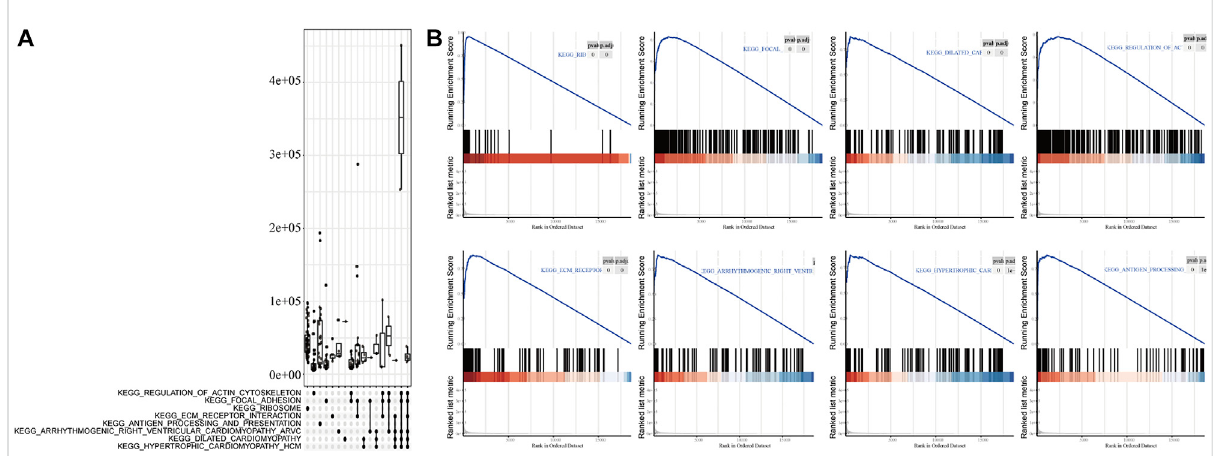
FIGURE 7 GSEA analysis based on differential expression of TCGA-STAD datasets. (A) Upper panel showed the GSEA analysis based on the differential expression of TCGA-STAD datasets. (B) Results showed tumor tissue with FLG mutation is closely related to ribosome, focal adhesion, dilated cardiomyopathy, regulation of action cytoskeleton, and ECM receptor interaction